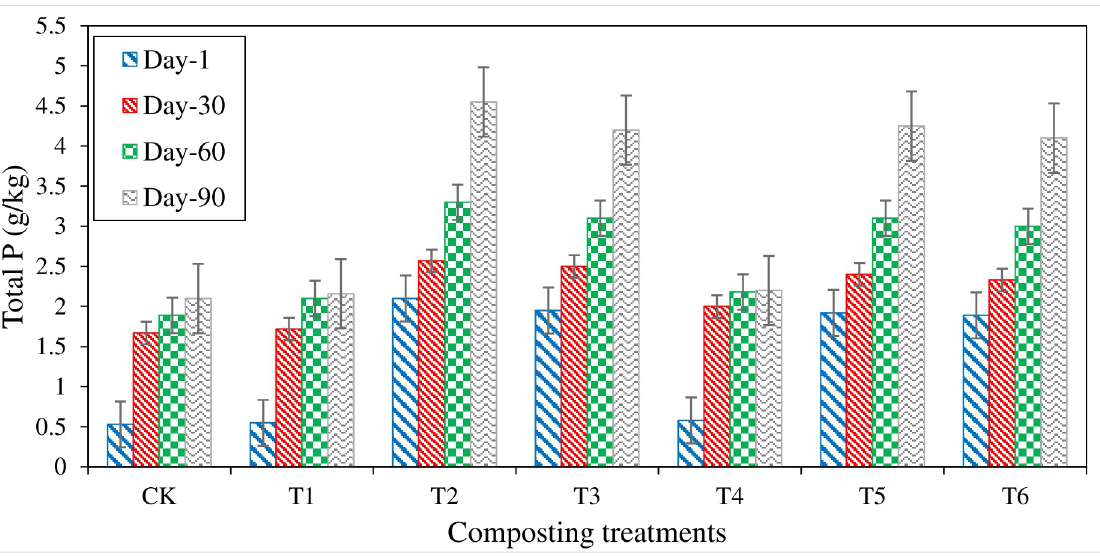
Fig 7. Total P content measured from different composting